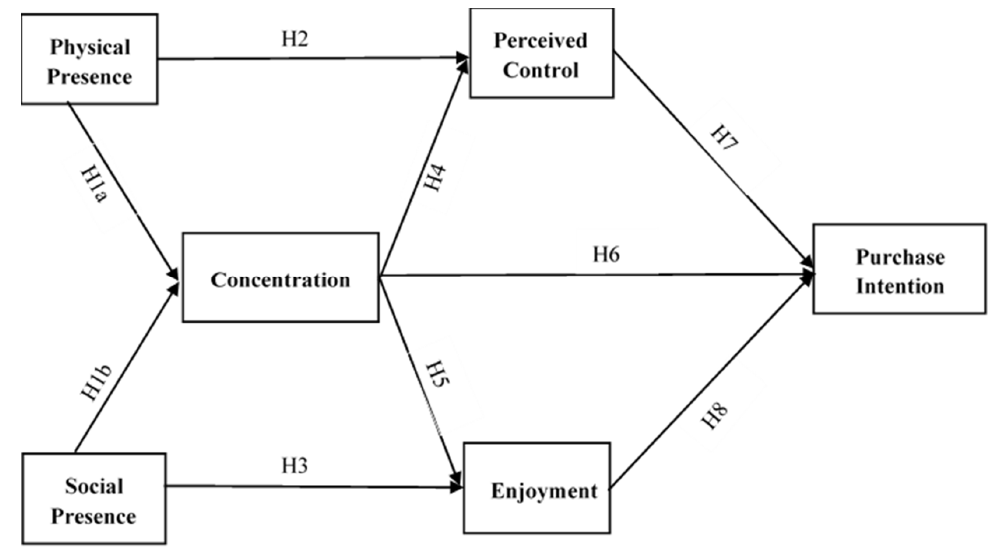
Figure 1. A research model on presence and purchase intention.